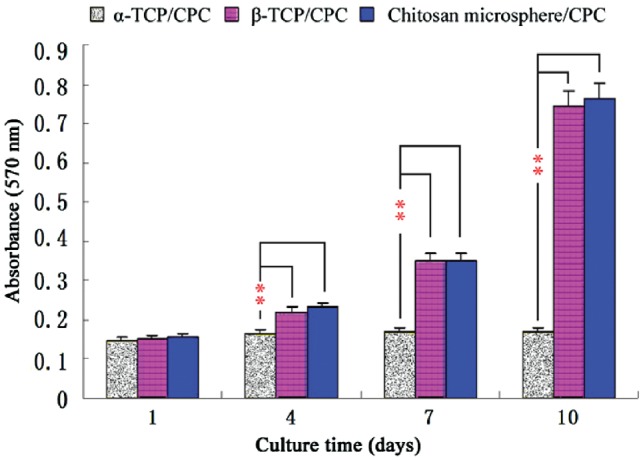
MTT Absorbance values of three types of material on different days (** P < 0.01)